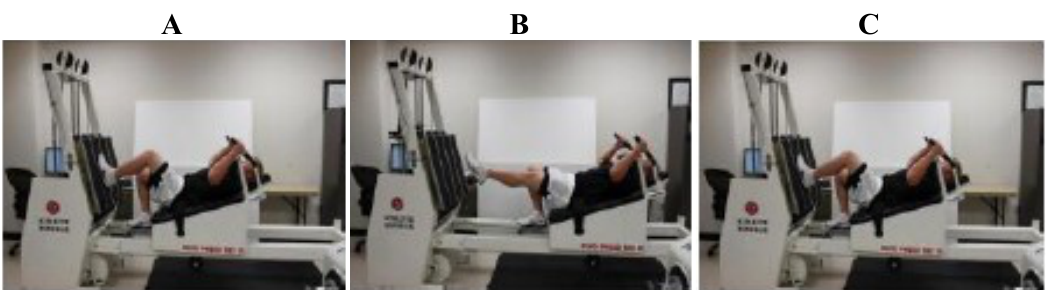
Figure 1. Examples of the single-leg strength testing and the intense-stretch shortening contraction (SSC) protocol on the horizontal Plyo-press. ( A ) The weight stack